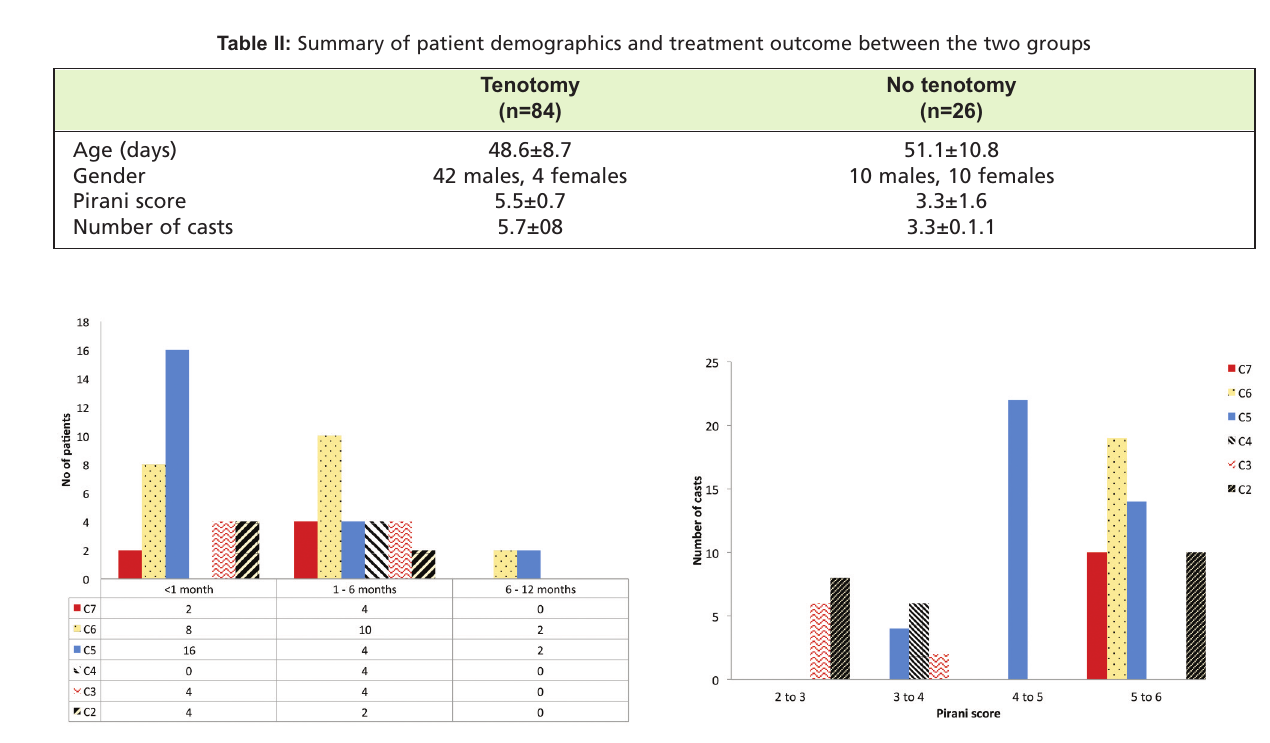
Age versus number of casts required. C represents Fig. 1: number of casts.